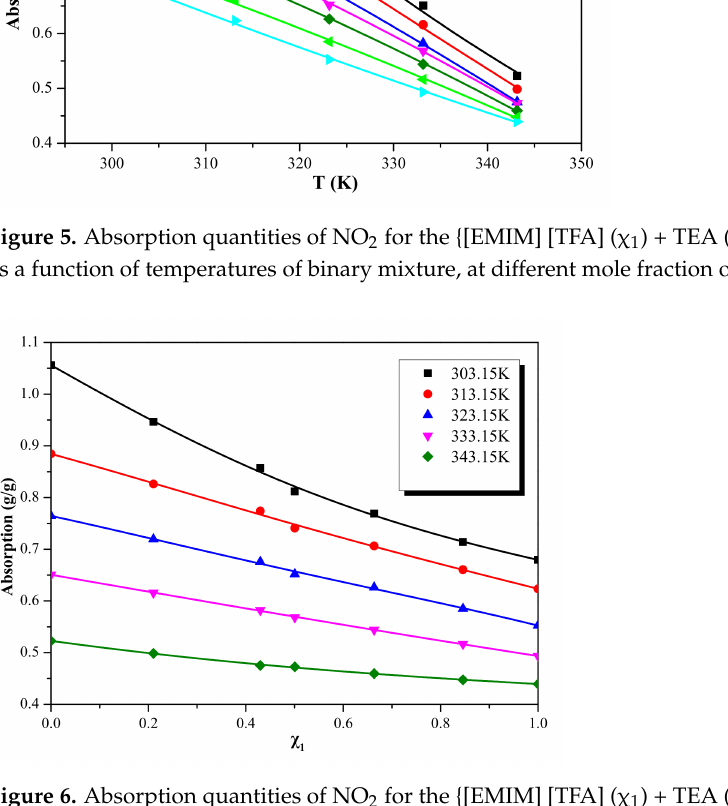
Figure 6. Absorption quantities of NO 2 for the {[EMIM] [TFA] ( χ 1 ) + TEA (1 − χ 1 )} binary systems, as a function of mole fraction of ILs, at several temperatures.